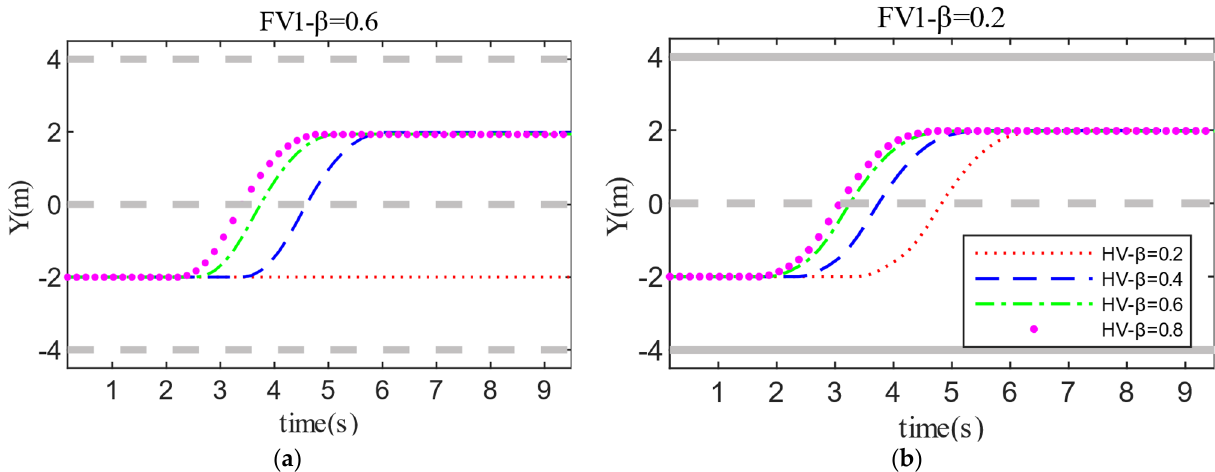
Figure 9. Test results for decision making and path planning in Scenario A: ( a ) FV1_ β = 0.6; ( b ) FV1_ β = 0.6.